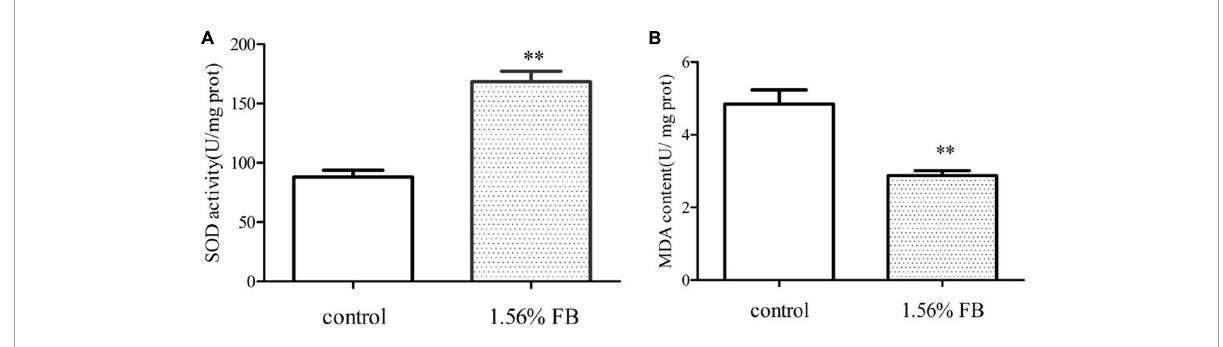
FIGURE8 Effect of FB on the activities of antioxidant enzymes. (A) SOD activity and (B) MDA content. Differences compared to the control group were considered significant at ** p < 0.01.